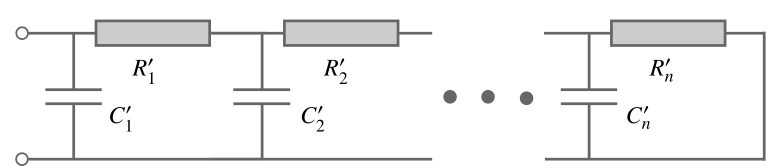
Figure 2. Cauer-type RC-ladder network with n sections. In this network, the resistances and capacitances correspond to the thermal equivalents in the device. As differentiation to the Foster network, Cauer-type components are denoted with a